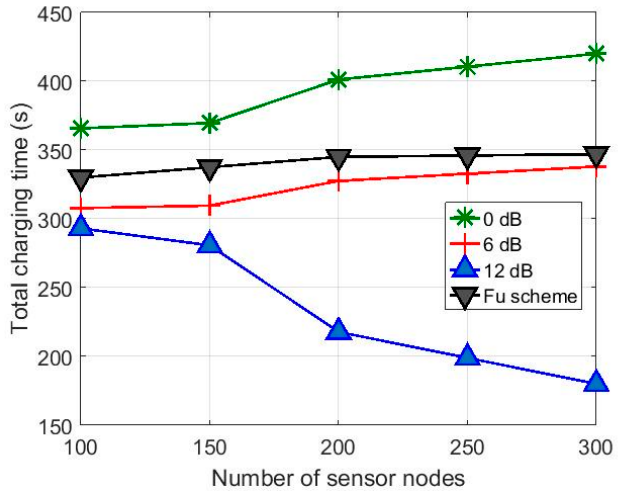
Figure 10. Variation of total charging time according to number of sensor nodes with different antenna gains for T f = 0.01.